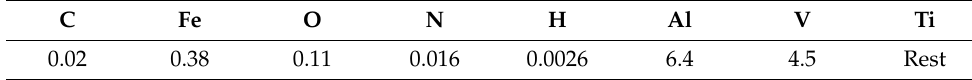
Table 1. Chemical composition of Grade 5 titanium alloy/wt.